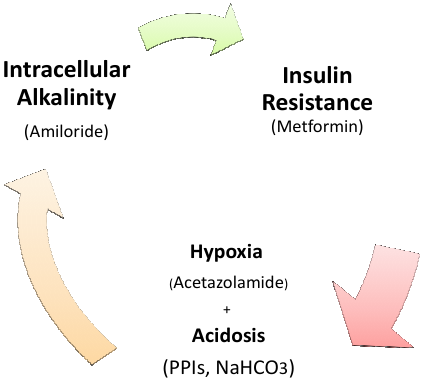
Figure 1. Describes the interaction between different key events of carcinogenesis, this figure represents the interaction of the possible three key events of carcinogenesis with potential antagonizing agents.